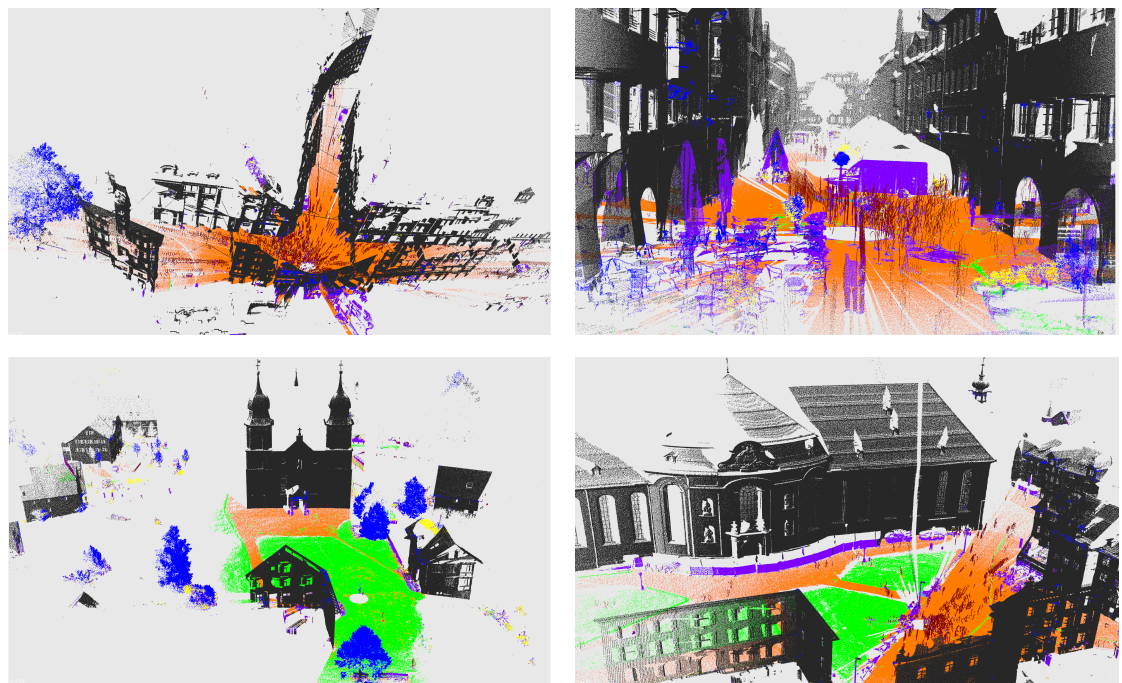
Figure 5. Results for terrestrial laser scans. Top row: urban street in St. Gallen (left), market square in Feldkirch (right). Bottom row: church in Bildstein (left), cathedral in St. Gallen (right) with classes: man-made terrain, natural terrain, high vegetation, low vegetation, buildings, remaining hard scape and scanning